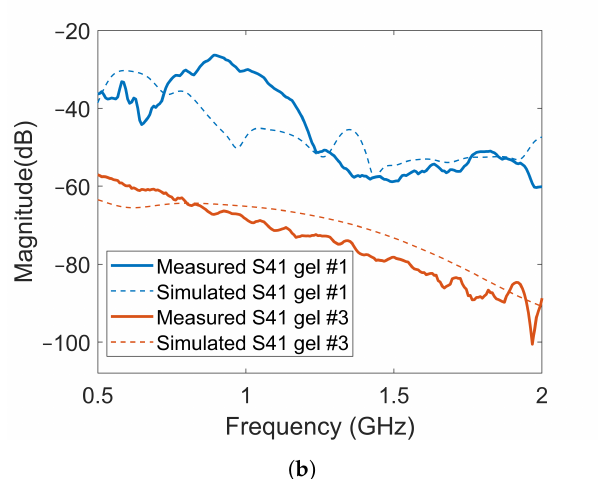
Figure 12. Comparison of transmission coefficients obtained from simulated and measured data for Gel #1 and Gel #3: ( a ) results for S21; ( b ) results for S41.